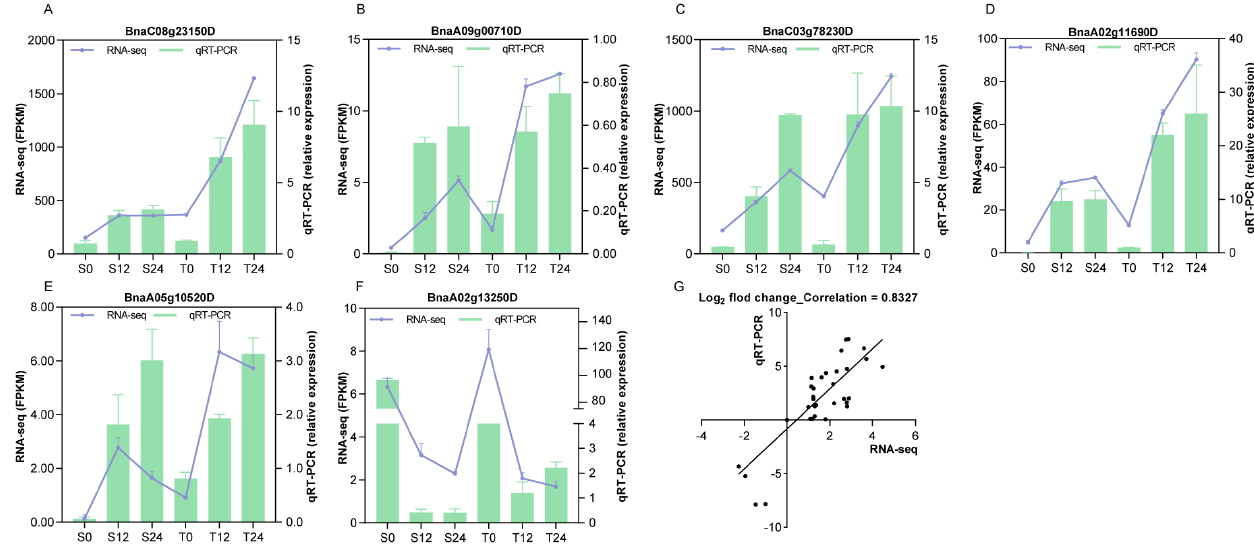
Figure 7. Validation of RNA − Seq transcriptional data using qRT-PCR. ( A − F ) Comparisons of RNA- seq data (By FPKM; green color bars) with qRT − PCR (By the relative expression of reference gene; purple lines) of randomly selected six genes. ( G ) The scatter plot shows the Pearson’s correlation of expression change by qRT − PCR (Y − axis) and RNA-Seq (X − axis).